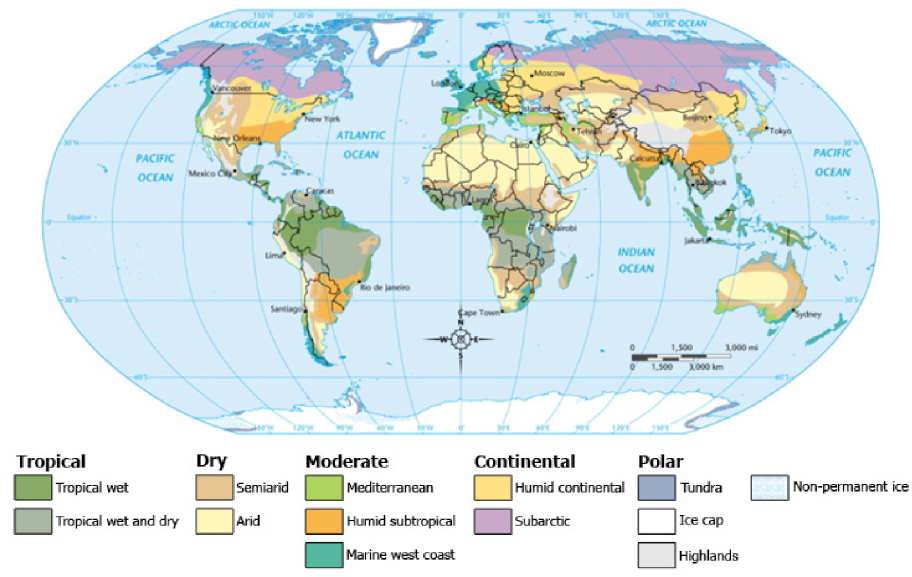
Figure 16. World climate